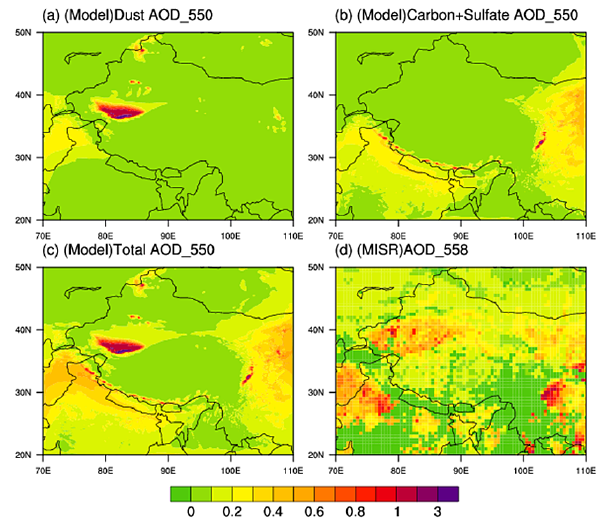
Figure 6. Monthly mean aerosol optical depths from the MISR and SPRINTARS simulations for August